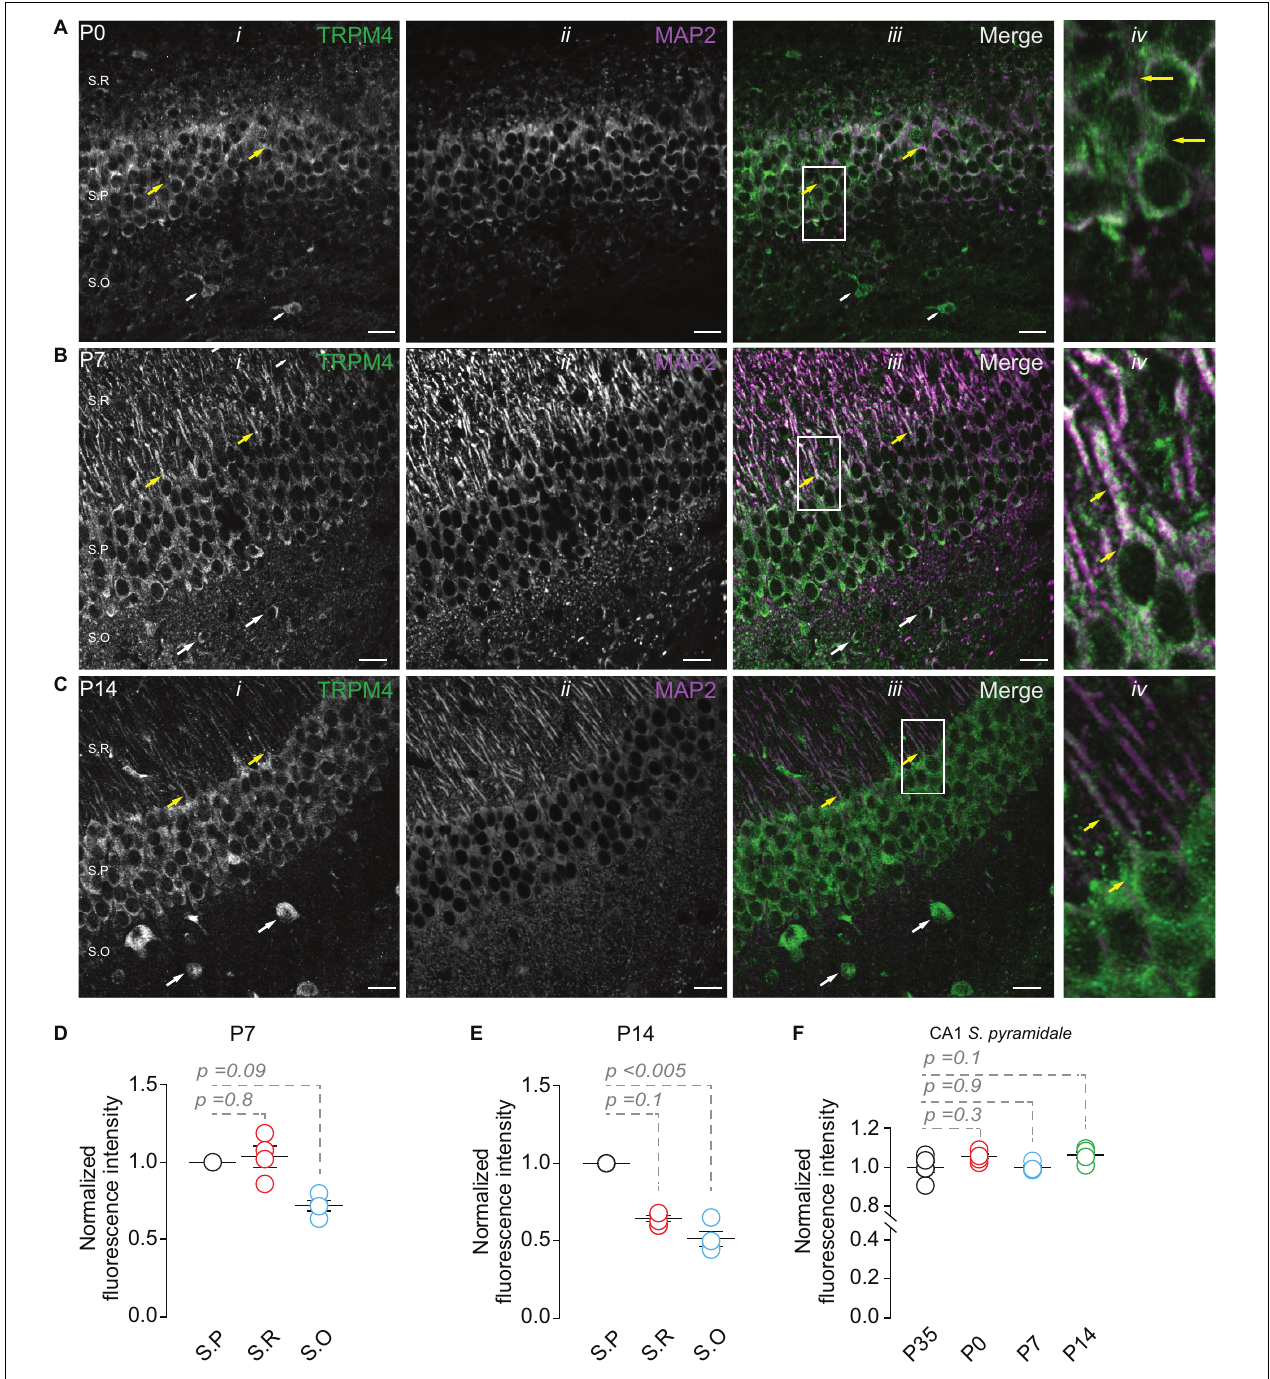
FIGURE 2 | TRPM4 expression in CA1 pyramidal neurons during postnatal development. Confocal images showing double labeling of TRPM4 (Alexa 488, green, i ) with MAP2 (Alexa 546, magenta, ii ), the merged signals ( iii ), and ( iv ) shows a zoomed area (white rectangle), yellow arrowheads showed neurons in the stratum pyramidale and the distribution in the soma and proximal apical dendrite; white arrowhead shows the distribution in the stratum oriens , showing the expression in the somatic region of the neurons. (A) Shows the expression of TRPM4 and MAP 2 at P0, (B) Shows the expression at P7, and (C) Shows the expression at P14. (D,E) Graphs of normalized fluorescence intensity of TRPM4 in S.P, S.R, and S.O of area CA1 of P7 and P14. Fluorescence intensity values were normalized to CA1 S.P. for each mouse. Each point corresponds to an individual mouse (Kruskal Wallis followed by Dunn’s post hoc test vs. CA1 S.P; n = 4 mice). (F) Graph of normalized fluorescence intensity of TRPM4 in S.P, from P0, P7, P14, and P35 mice. Fluorescence intensity values were normalized to mean intensity values of CA1 S.P of P35 mice. Each point corresponds to an individual mouse (Kruskal Wallis followed by Dunn’s post hoc test vs. CA1 S.P, P35; n = 4–5 mice). S.P, stratum pyramidale ; S.R, stratum radiatum ; and S.O, stratum oriens . Calibration bars = 20 µ